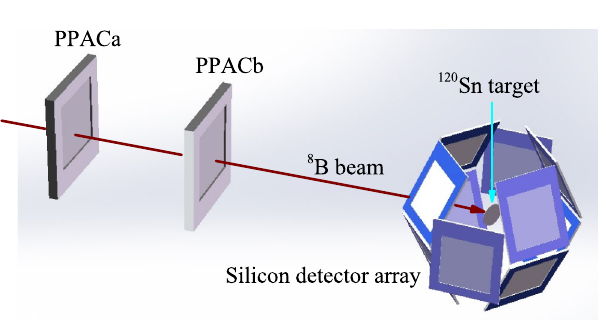
Fig. 5 | Schematic view of the experimental setup. The upstream and down- stream parallel plate avalanche counters (PPACs) are denoted as the PPACa and PPACb, respectively. Ten silicon detector telescopes surround the 120 Sn target,